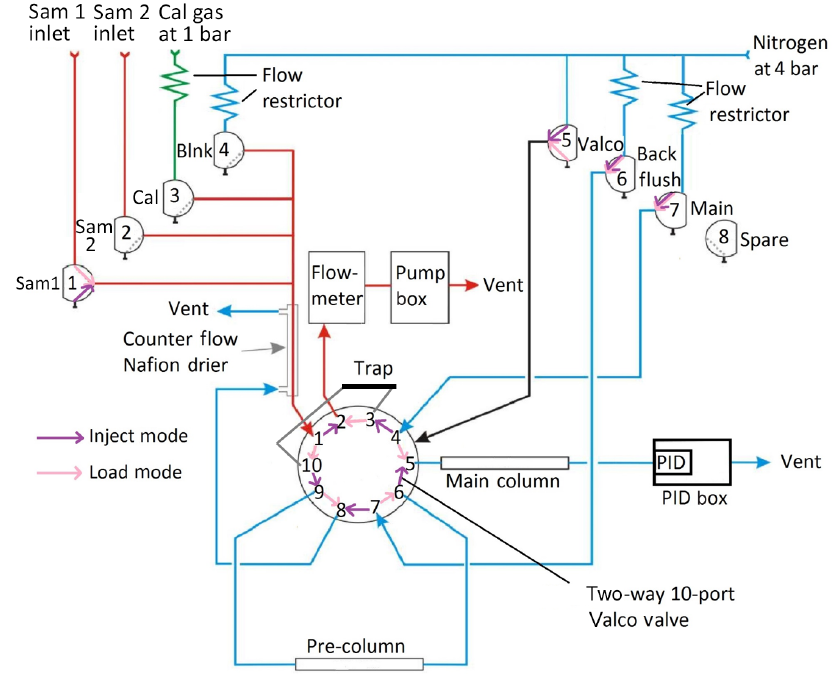
Figure 2. Schematic representation of the iDirac operation. When in load mode (valve 5 off – pink), the contents of a gas source chosen between valves 1, 2, 3 and 4 are pre-concentrated on the adsorbent trap. In inject mode (valve 5 on – purple), the VOCs in the trap are injected into the dual-column system for separation and, eventually, detection. (“Sam” refers to sample, “Cal” refers to calibration and “Blnk” refers to